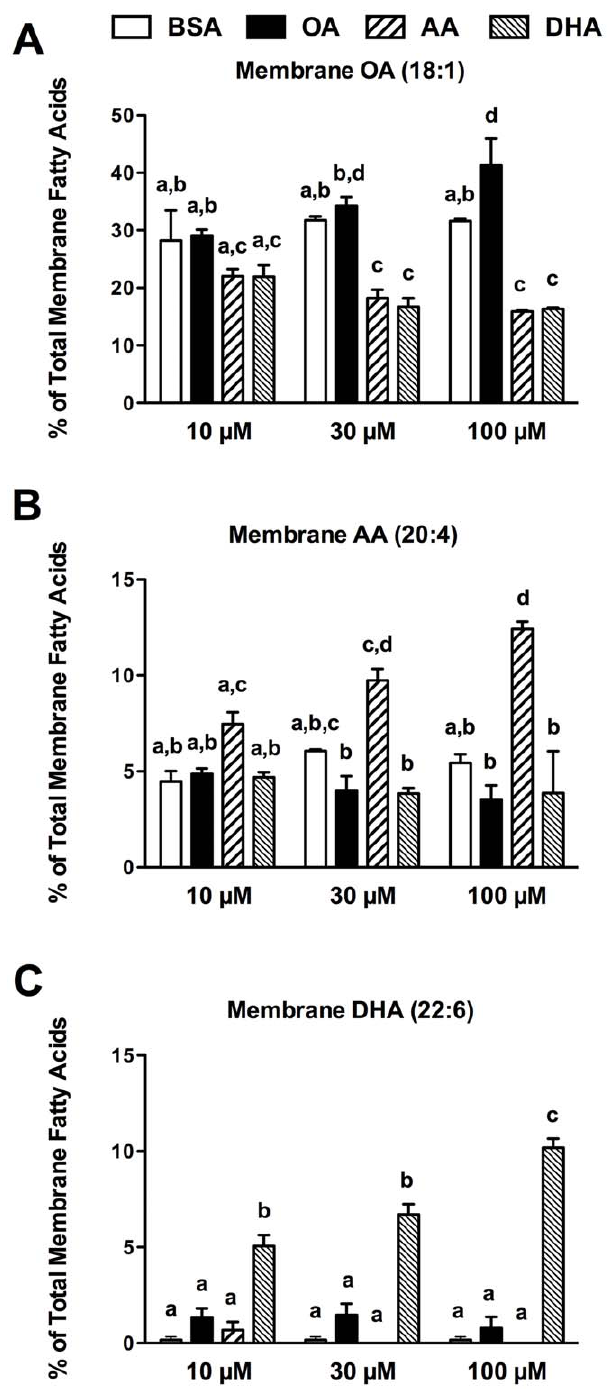
Figure 1. Membrane fatty acid composition of PHM1-41 cells treated with 10 m M, 30 m M, 100 m M of OA, AA, DHA. Membrane (A) 18:1 OA, (B) 20:4 AA, (C) 22:6 DHA are shown as a percent of total membrane fatty acids. Values are mean percent 6 SEM (n=3 experiments). Bars not sharing common letters are significantly different between treatment groups, p ,